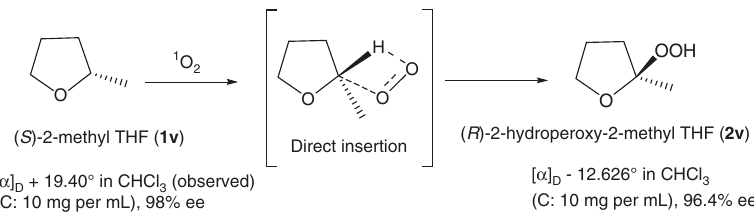
Fig. 3 Direct C – H bond insertion and retention of con fi guration. Mechanistic study for singlet O 2 -mediated direct aliphatic α -ethereal C – H oxidative functionalization of ( S )-2-methyl THF. The optical rotation and ee values are based on experimental measurements (see Supplementary Fig. 32 –